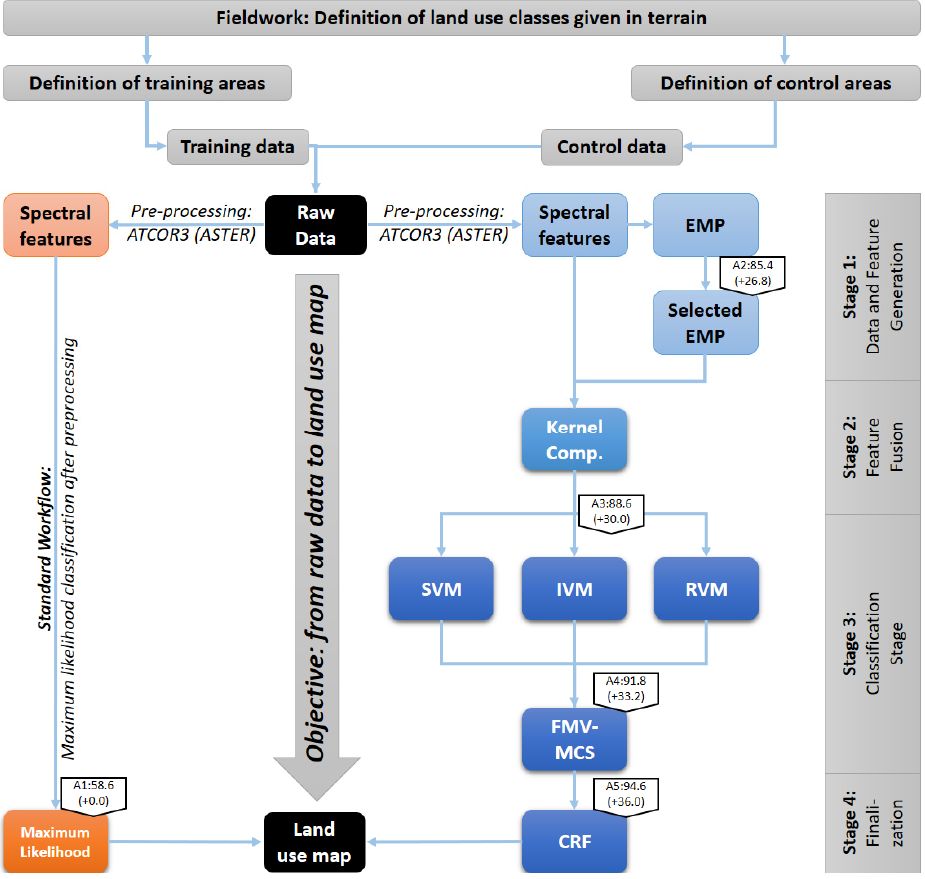
Figure 1. Overview of the classification framework developed in Braun et al. [50] and employed herein in comparison to a standard workflow (Maximum Likelihood Classification). EMP: Extended Morphological Profile, Kernel Comp.: Kernel composition: SVM/IVM/RVM: Support/Import/Relevance Vector Machine, FMV-MCS: Fuzzy Majority Voting Multiple Classifier System, CRF: Conditional Random Field. Values in White Polygons: Accuracy Value A and increase of accuracy over comparison approach (Maximum Likelihood).